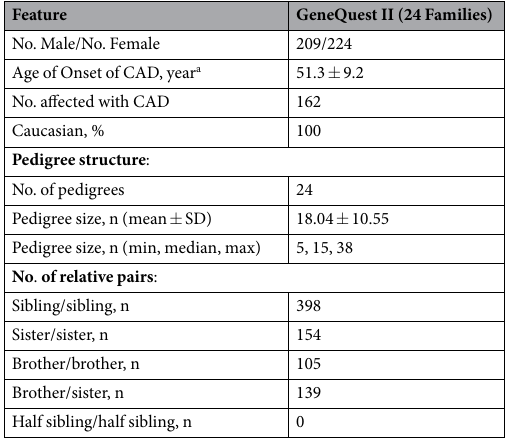
Table 1. Clinical and Demographic Characteristics of the GeneQuest II Study Population. a Data were shown as mean ±